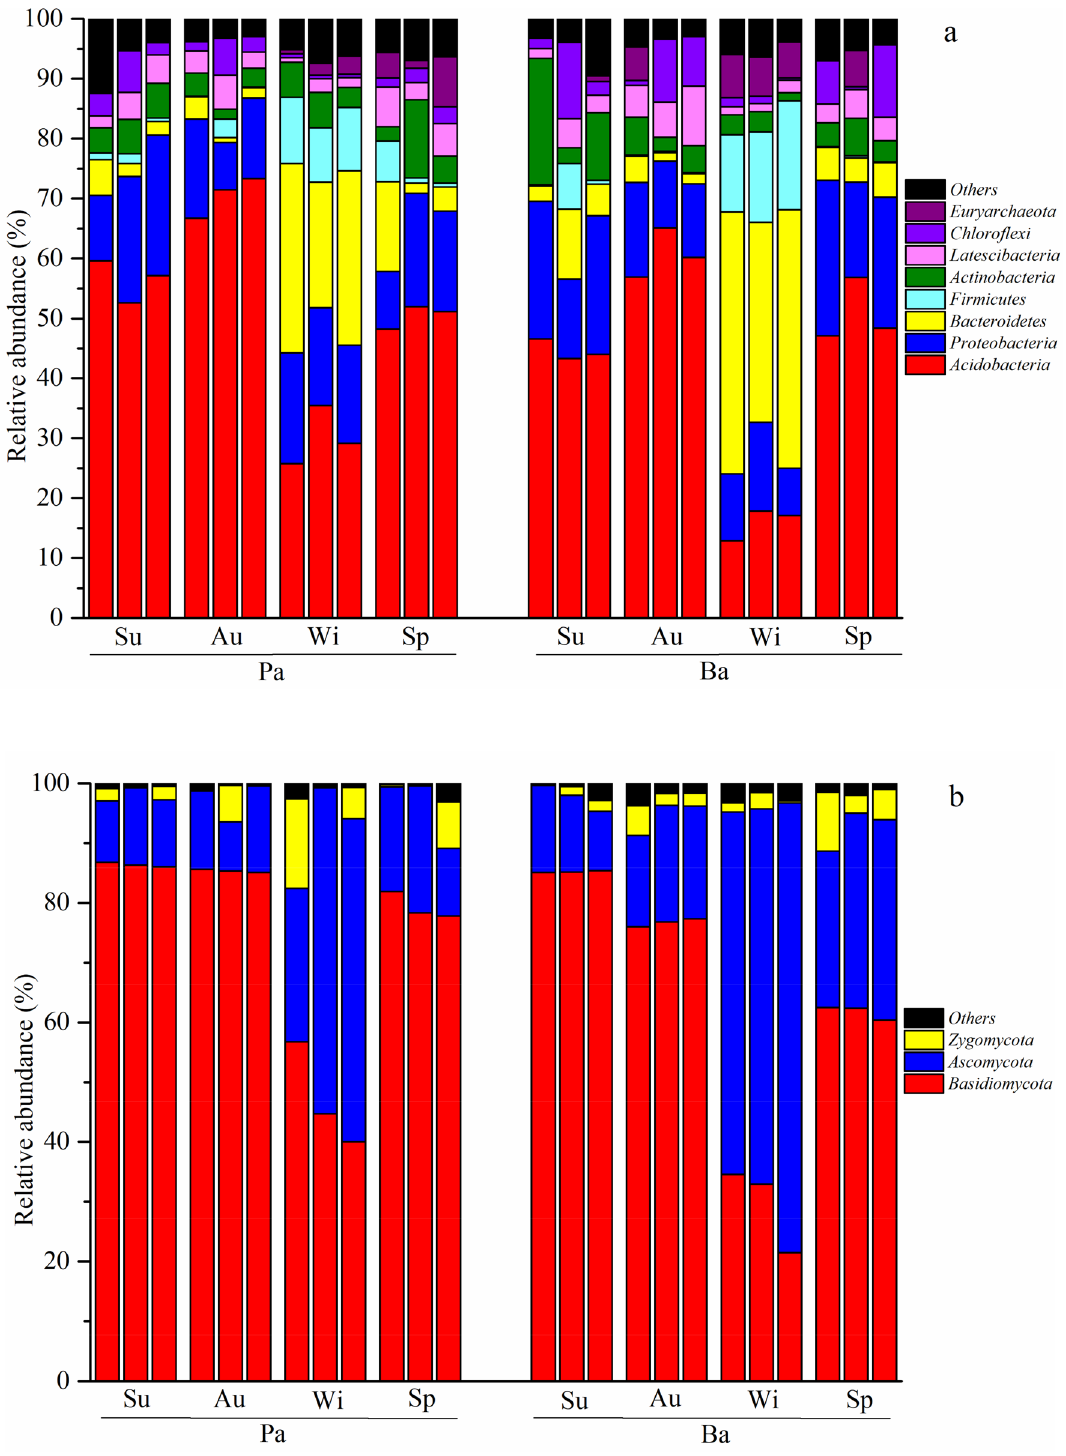
Figure 3. Distribution of the 16S rRNA ( a ) and ITS ( b ) sequences across the bacterial communities. Sp, Su, Au and Wi represent spring, summer, autumn, and winter, respectively (his figure is made by Origin, version 9.0, 2012, OriginLab, Northampton, MA, USA; software available at: https ://www.origi nlab.com/;